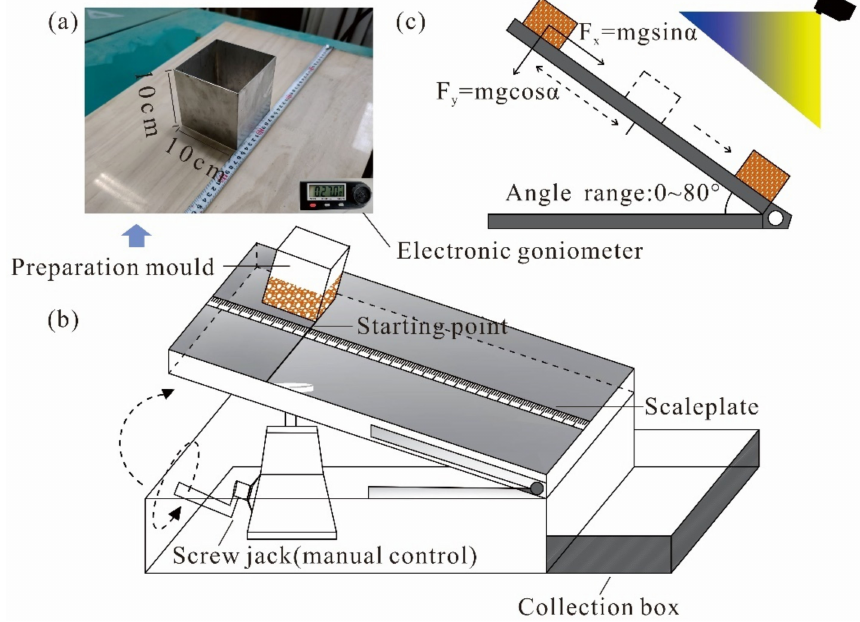
Figure 1. Model test devices: ( a ) sample preparation mold; ( b ) indoor sliding test model; ( c ) angle range and force analysis.